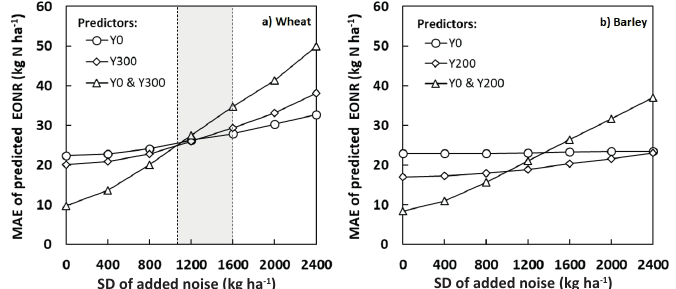
Fig. 3. Mean absolute error (MAE) of predictions of economic optimal nitrogen rate (EONR) in relation to the magnitude of random errors added to the predictor variables. The grey area in diagram (a) indicates the range of reported error levels for yield prediction based on proximal sensing (Øvergaard et al. 2013, Engström and Piikki 2016).